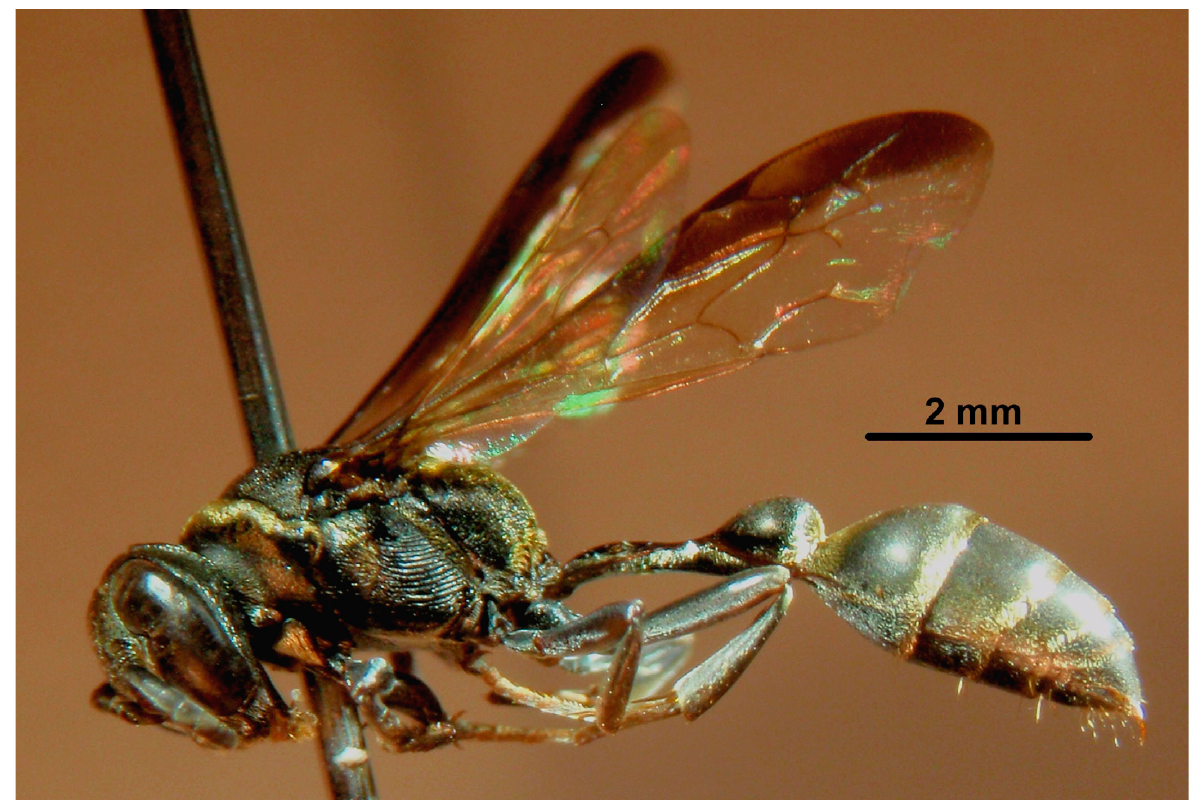
Figure 1. Aulacophilus chrysotrichus Antropov, 1999, female, lateral view